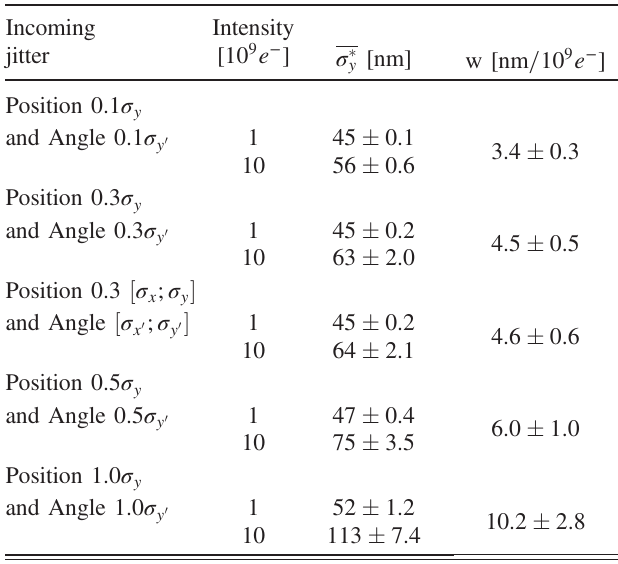
TABLE V. Simultaneous impact of the incoming position and angle jitters on the average vertical IP beam size ( σ (cid:1) y ), at low and high beam intensities, calculated with PLACET